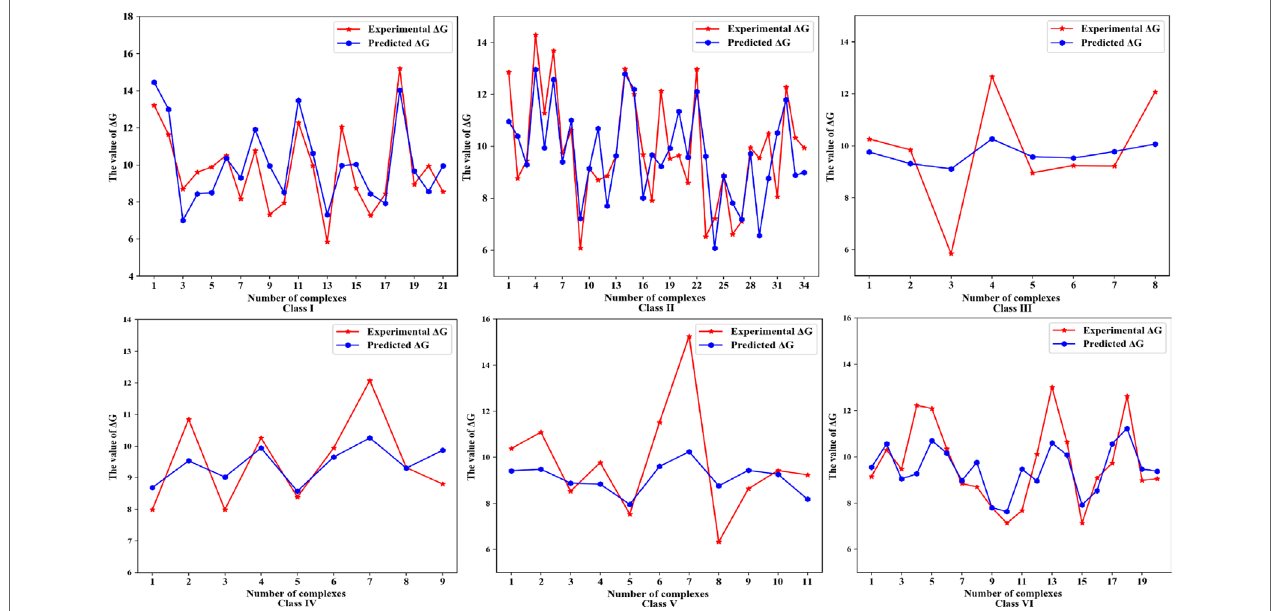
FIGURE 3 | The predicted and actual binding affinities, represented by Δ G , of each protein-RNA complex in six classes of